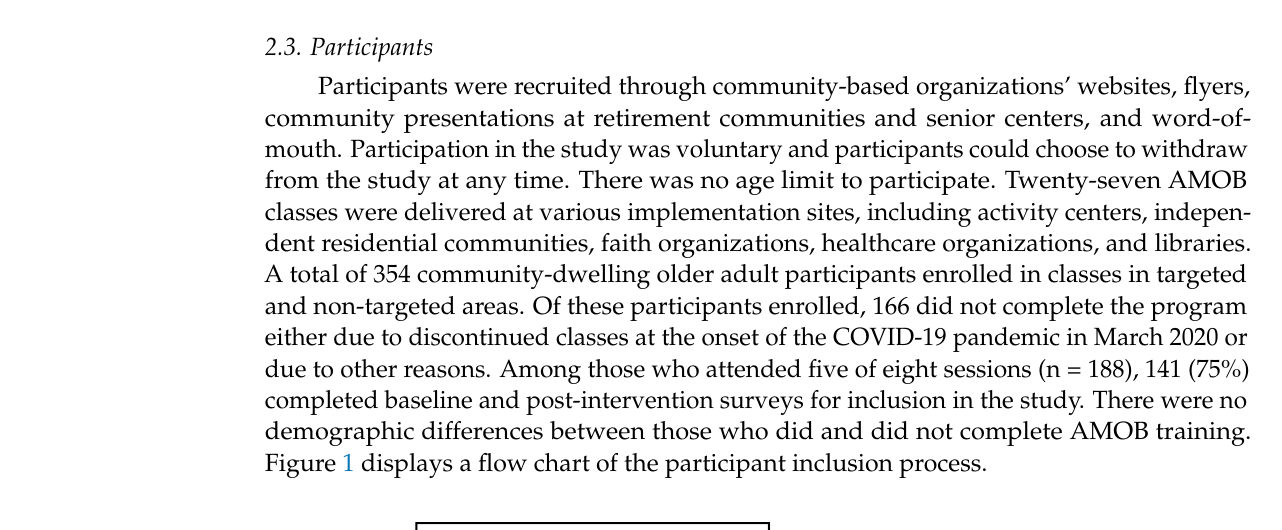
Table 1. Age-Friendly Health System 4Ms components of A Matter of Balance (AMOB) model.